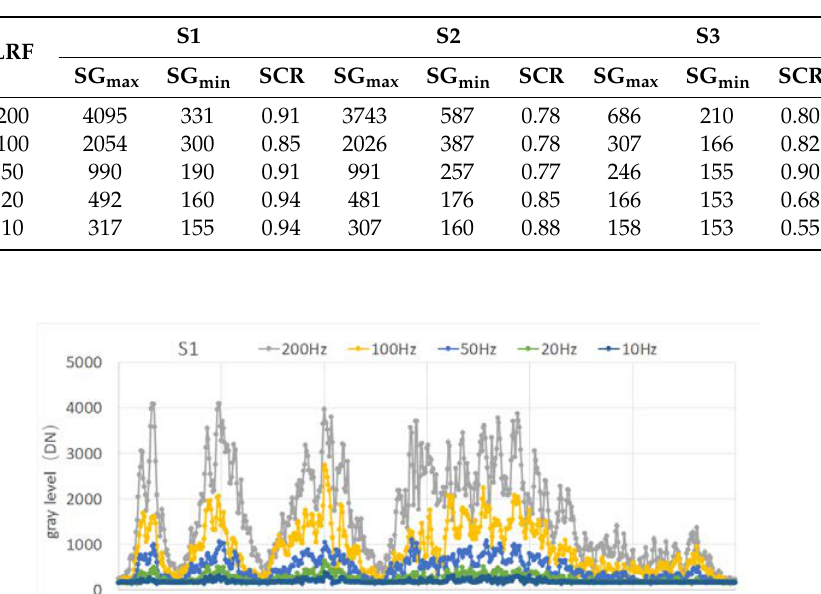
Table 2. Statistical results of the contrast. SG max : Max Gray (Unit: DN); SG min : Min Gray (Unit: DN); SCR: stripe contrast ratio; LRF: laser repetition frequency (Unit: Hz), DN: digital number (one grayscale unit).